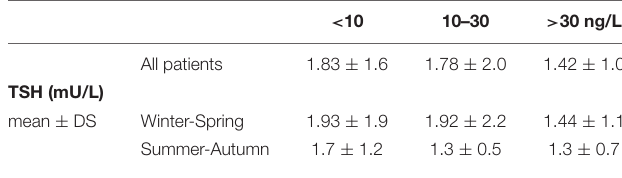
TABLE 1 | TSH values according to 25(OH)D status in the overall population and in different